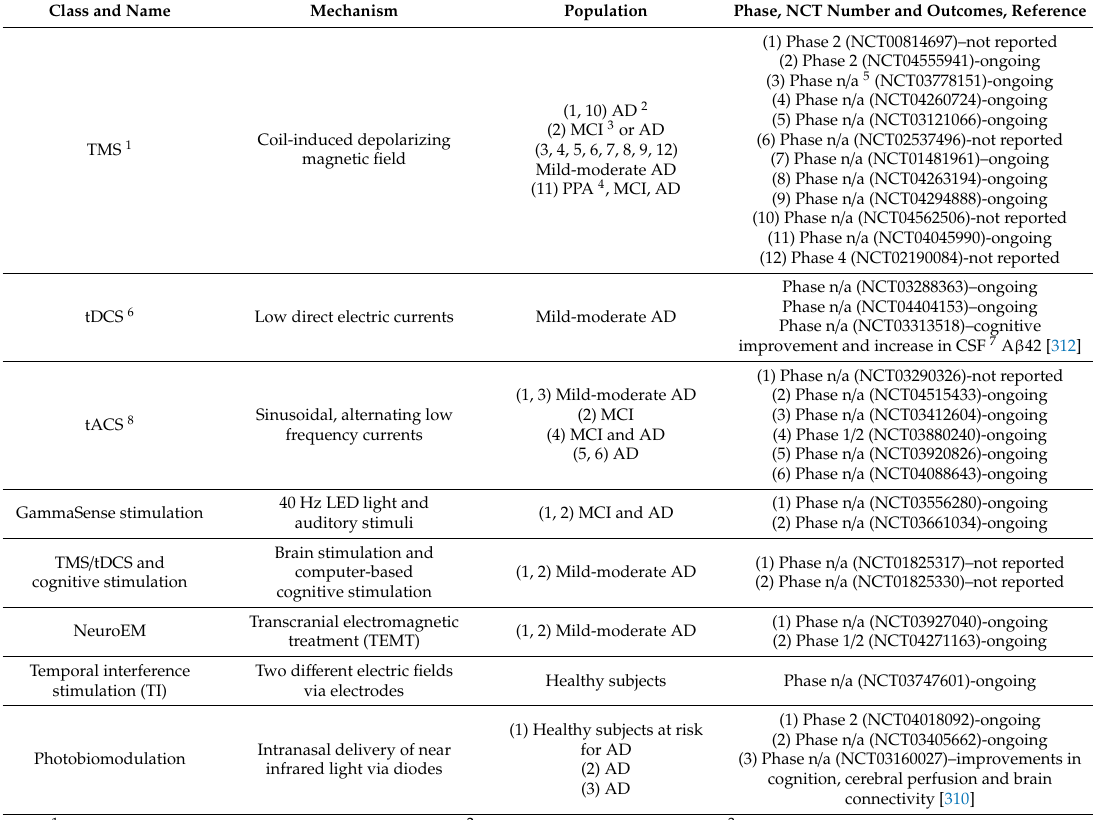
Table 4. Non-pharmacological brain stimulation techniques for reducing brain